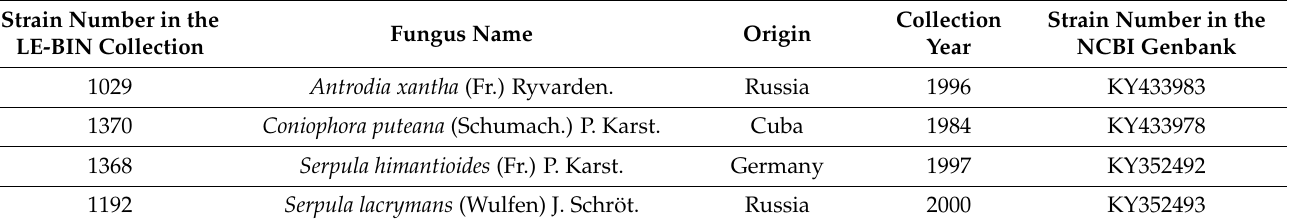
Table 2. Characterization of brown rot fungi strains from Komarov Botanical Institute Basidiomycetes Culture Collection (LE-BIN, WDCM1015).